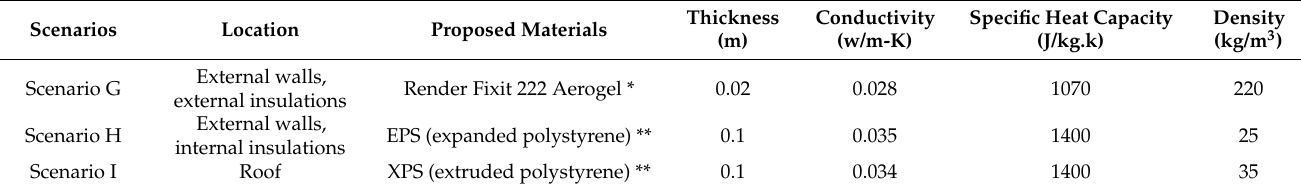
Table 6. List of insulation materials that were